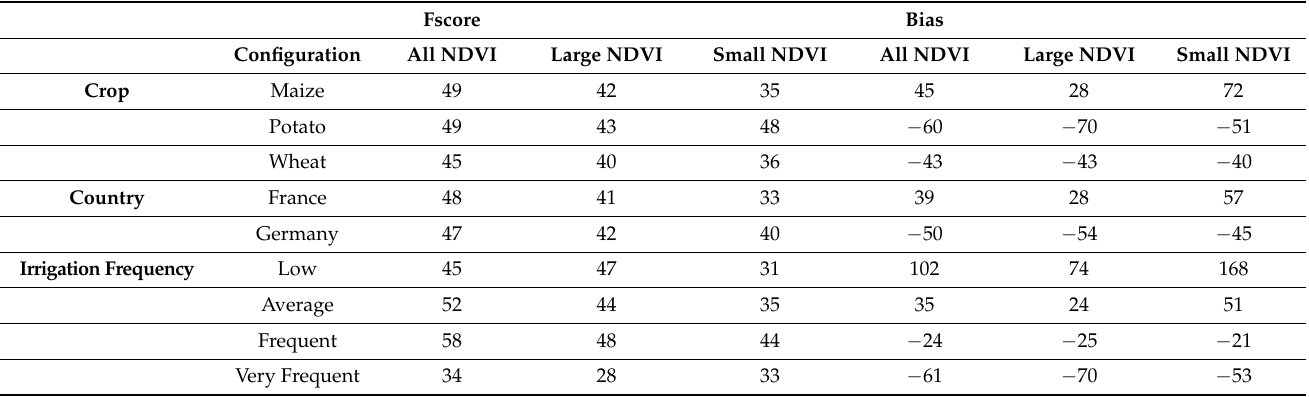
Table 6. Scores (F-score, bias) of the interpolated approach according to different configurations orbit, incidence angle, crop, country, irrigation frequency), and the level of NDVI (all data, small NDVI values, high NDVI